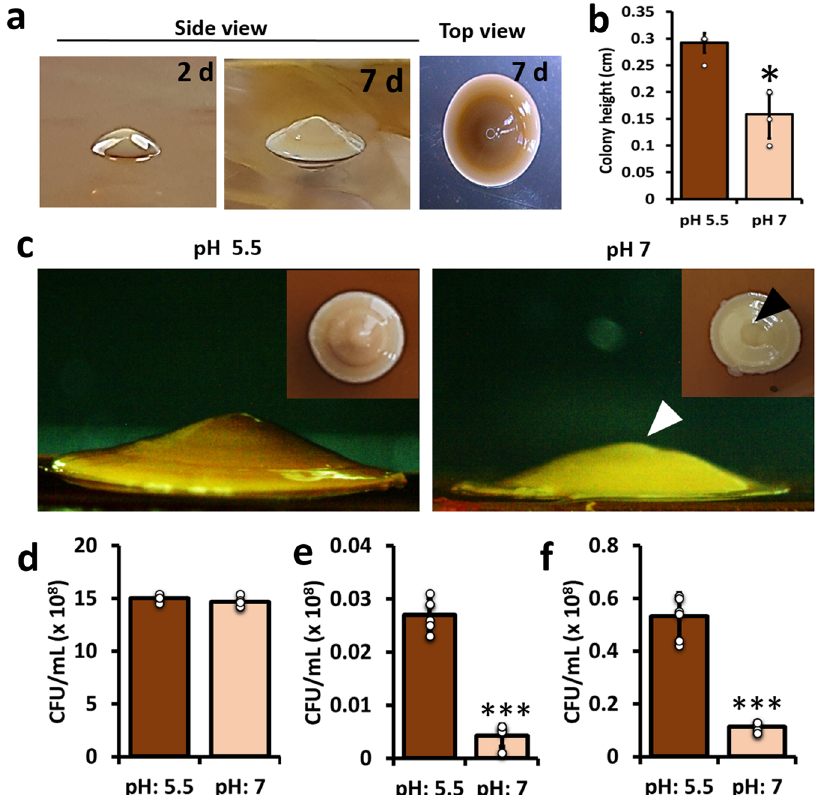
Fig. 1 Spatiotemporal establishment of conic-shaped colonies in L. plantarum . a Colonies of L. plantarum 3297 were generated onto the MRS hard agar plates (pH 5.5) following 2 and 7d incubation at 37 °C. Scale bar: 0.2 cm. b Estimation of the L. plantarum 3297 colony heights generated on the MRS hard agar plates with different pH conditions. The graph shows the means ± SEMs of 6 individual data points, obtained from two independent measurements. * P < 0.05 vs. the control. Here, the colonies grown at pH 5.5 are taken as control compared to those grown at pH 7. c Effect of Δ pH on conic tip formation and colouration of the L. plantarum colonies. White and black arrowhead show the abolished tip. Scale bar: 0.1 cm. d The CFU quantitation of L. plantarum 3297 cells grown at pH 5.5 and 7 after 7 d of incubation on MRS hard agar. The graph shows the means ± SEMs of individual data points, obtained from two independent measurements. * P > 0.05 vs. the control. Here, the colonies grown at pH 5.5 are taken as control compared to those grown at pH 7. e The CFU quantitation of L. plantarum 3297 cells exposed to desiccation stress. The cells were prior grown on MRS hard agar at pH 5.5 or 7 for 7d. After incubation, the conic colonies were directly transferred to the desiccation unit (at 40% relative humidity and 30 °C for 4 d). The graph shows the means ± SEMs of 9 individual data points, obtained from three independent measurements. *** P < 0.001 vs. the non-treated controls. f The CFU quantitation of L. plantarum 3297 cells exposed to desiccation stress. The cells were prior grown on MRS hard agar at pH 5.5 or 7 for 7d. After incubation, the conic colonies were directly transferred to the desiccation unit (at 40% relative humidity and 30 °C for 20 h). The graph shows the means ± SEMs of 9 individual data points, obtained from three independent measurements. *** P < 0.001 vs. the non-treated